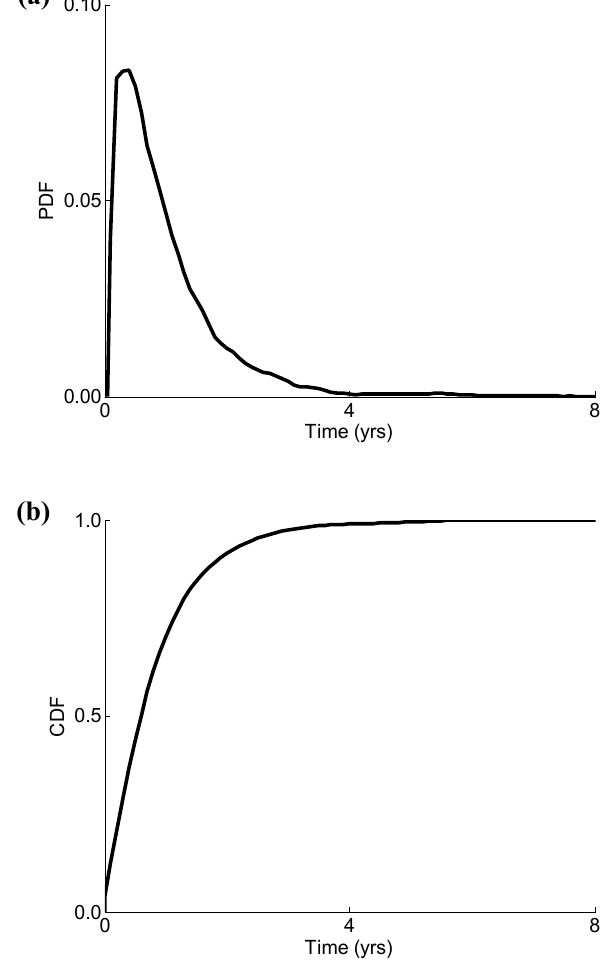
Fig. 4. Characteristic distributions summarizing (a) probability density function (PDF) and (b) the cumulative distribution function (CDF) of the spatially distributed travel times given in Fig.